Question: What direction does the quantity move in — increasing or decreasing?
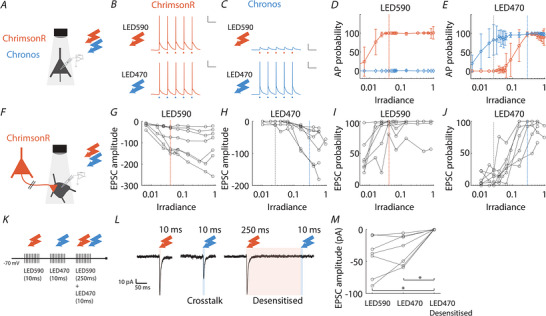
Answer: increasing